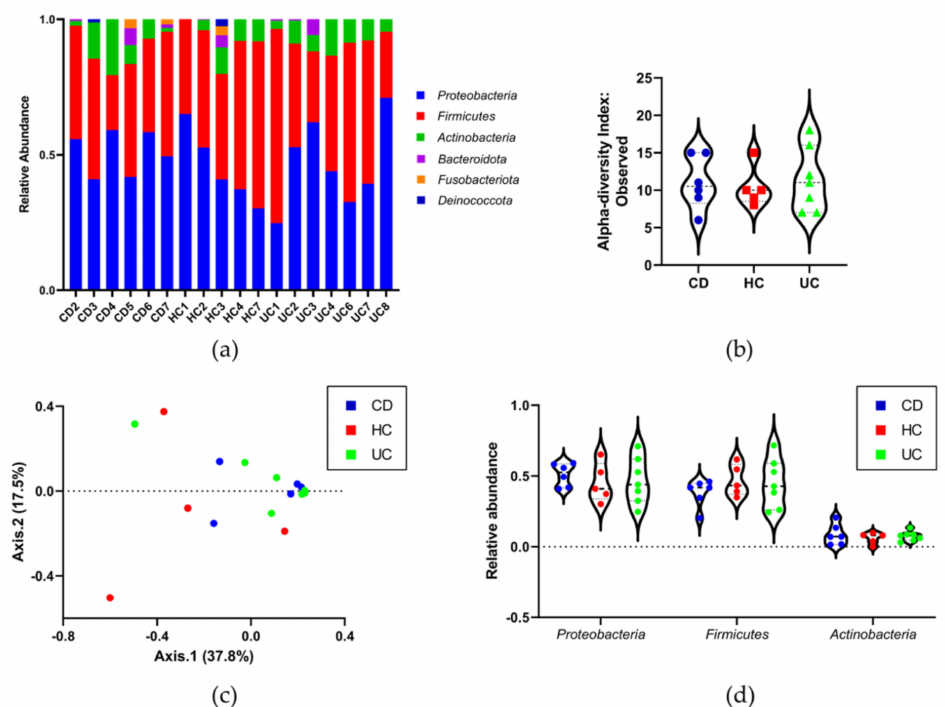
Figure 5. Microbial diversity and richness. Sequence-based filtering was performed to remove repre- sentative protocol control reads with >20% prevalence in the plasma samples. ( a ) The most abundant taxa at the phylum level were Proteobacteria , Firmicutes, and Actinobacteria . ( b ) Microbial richness and diversity were not significantly different between groups. The α -diversity plot shows no significant difference between groups (ASV-level Observed Index: number of unique ASVs observed per sample and one-way ANOVA p -value: 0.89198), and ( c ) the β -diversity PCoA plot also shows no signifi- cant differences between the groups (ASV level: Bray-Curtis Index and permutational MANOVA (PERMANOVA) p -value: 0.276). ( d ) There were also no significant changes in relative abundance at the phylum level ( Proteobacteria , Firmicutes, and Actinobacteria one-way ANOVA p -values: HC vs. CD 0.7044, 0.4811, and 0.6117, respectively; HC vs. UC 0.9763, 0.9646, and 0.8331, respectively; FDR p -values: HC vs. CD 0.4954, 0.3127, and 0.4148, respectively; HC vs. UC 0.8620, 0.8311, and 0.6269, respectively. Violin plots with individual values demonstrating frequency distribution: dotted lines represent the upper and lower quartiles, and the central dashed line represents the median. Healthy controls (HC; red), Crohn’s disease (CD; blue), and ulcerative colitis (UC;